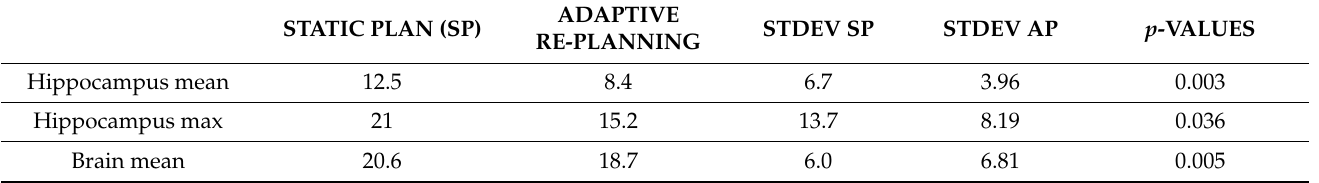
Table 2. Statistical data for static and adaptive plans. All numbers shown are in units of Gy. Sum hippocampus refers to the accumulated dose between the left and right hippocampi (involved hippocampi excluded).